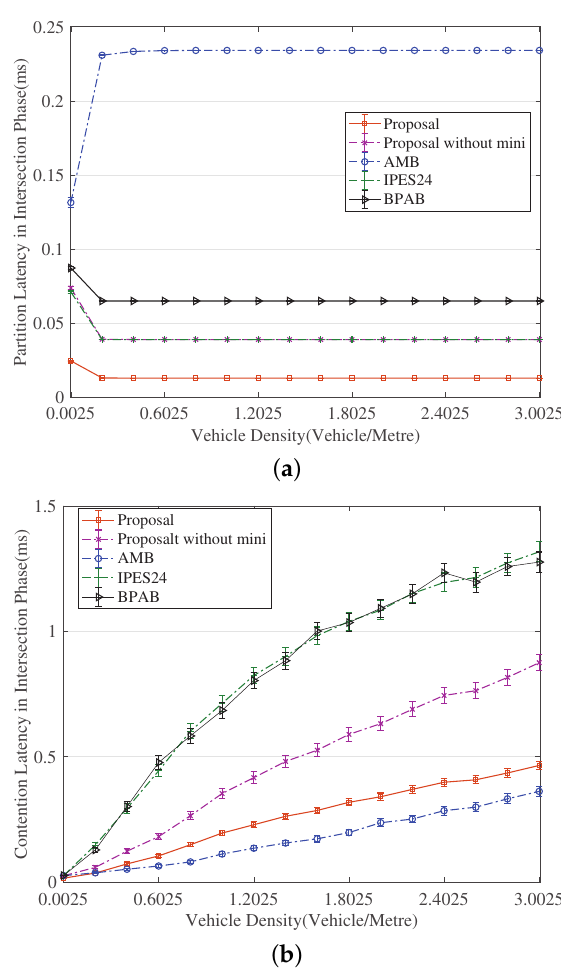
Figure 9. Comparison of Latency in Intersection Phase. ( a ) Comparison of partition latency; ( b ) Comparison of contention latency.